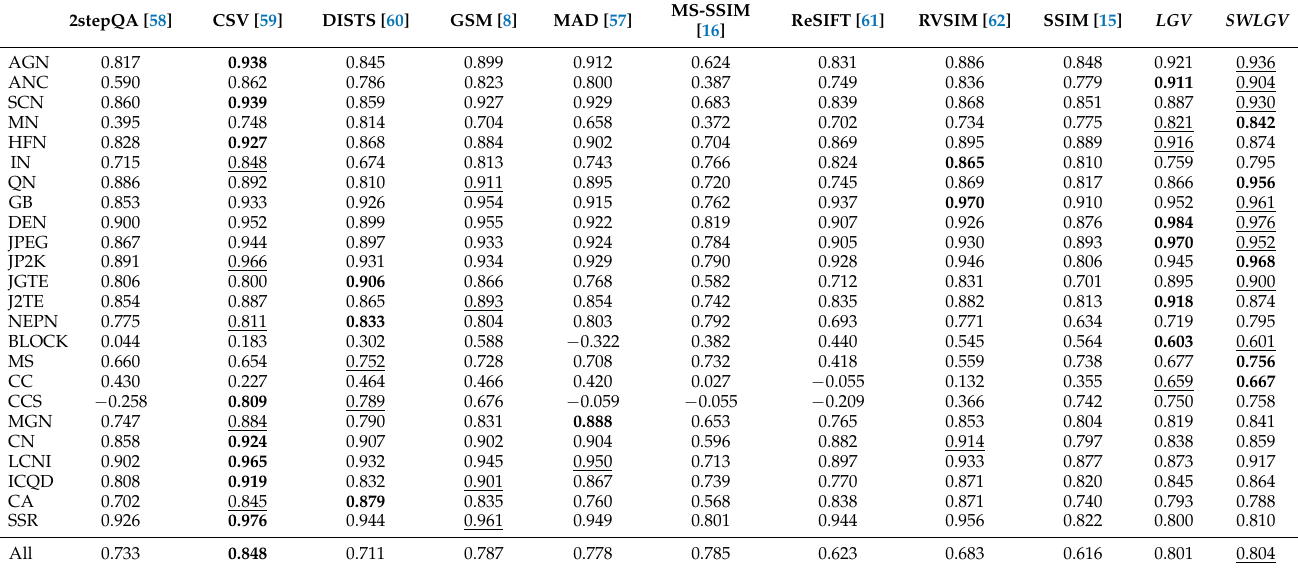
Table 7. Comparison on TID2013’s [3] distortion types. SROCC values are given. The highest values are typed in bold , while the second highest ones are